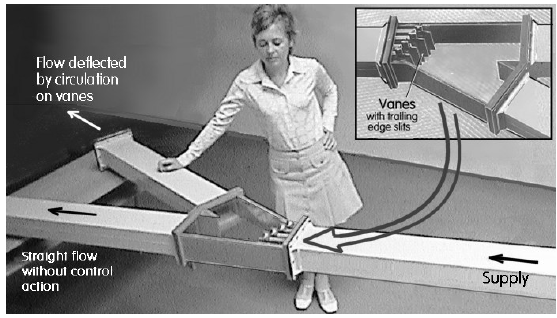
Fig. 6. Fluidic diverter valve in the 100 mm x 150 mm laboratory-tests rectangular section ducts. The unusual method of flow deflection tested in this case was the circulation on fixed (non-movable) four parallel vanes with control jets attaching by Coanda-effect to vane trailing